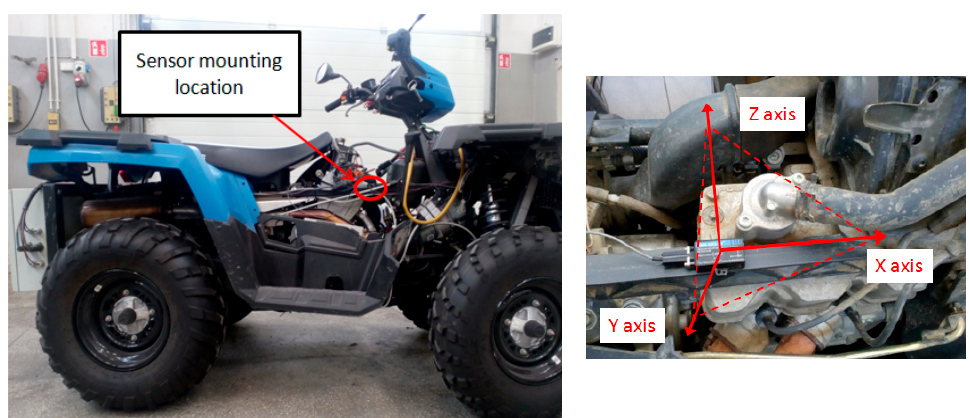
Figure 1. Sensor mounting location, sensor axis system.